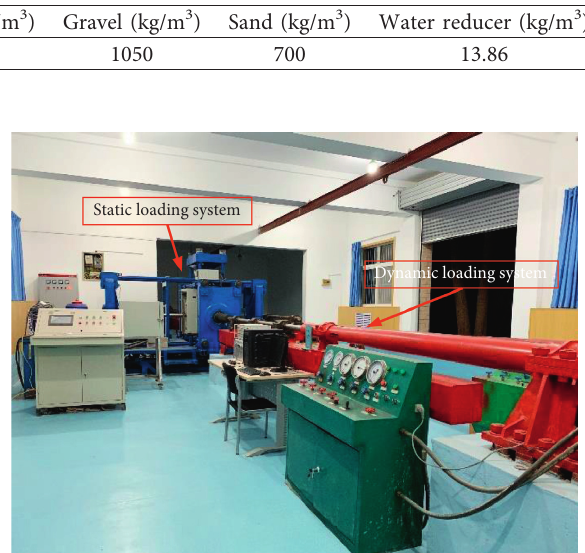
Table 4: Mix proportion of concrete.